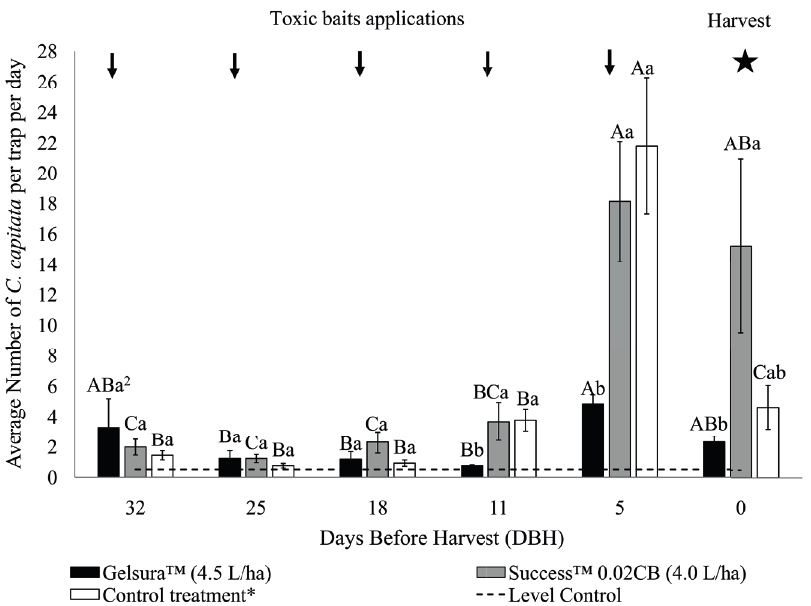
Figure 3 - Number of Ceratitis capitata captured in four Jackson traps on ‹Arra-15› grapevines during the six-week evaluation period in plots with Gelsura™ toxic baits (1:2 parts of water) and Success™ 0.02 CB (1:1.5 parts of water). Area 3: Lagoa Grande, PE, November/December, 2017. 2 Number of fl ies per trap per day (FTD) followed by equal capital letters over the course of six weeks of evaluation and by the same lowercase letters within the evaluation week do not diff er (Tukey’s test at 5% probability of error). Dashed line indicates the level of control (0.5 FTD). *Control plot with the application of